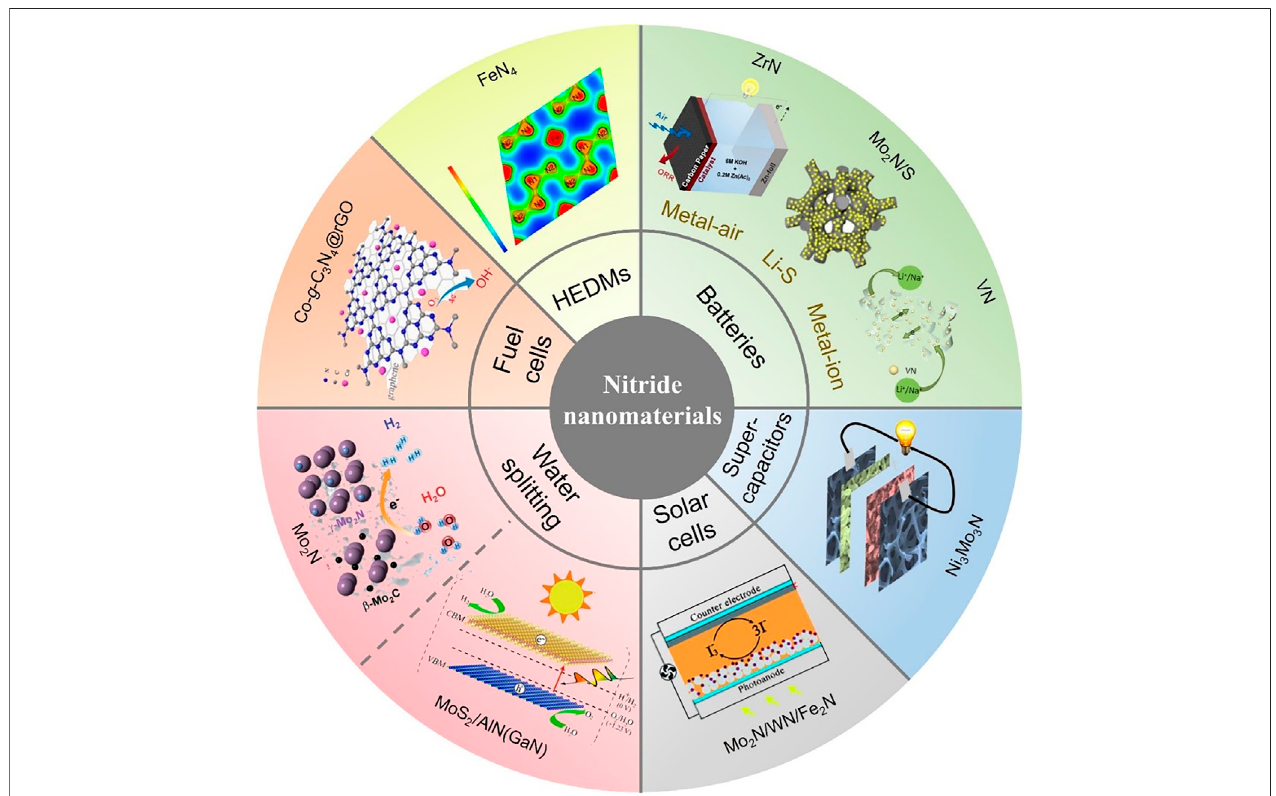
FIGURE 1 | Overview of inorganic nitride nanomaterials for renewable energy applications, including ZrN for zinc-air batteries, mesoporpus Mo 2 N/S for Li-S batteries, hybrid 2D – 0D Graphene – VN quantum dots for lithium and sodium ion batteries, Ni 3 Mo 3 N 3 nanorods for supercapacitors, Mo 2 N or WN or Fe 2 N for solar cells solar cells, heterostructural MoS 2 /AlN(GaN) for photocatalytic water splitting, 3D porous Mo 2 N for electrocatalytic hydrogen evolution, 2D Co-g-C 3 N 4 bulk for fuel cells and FeN 4 as high energy density materials. The inserted graphics are adapted with permission from Li et al. (2011), Chen et al. (2013), Liu and Zhang (2013), Liao et al. (2014), Wang et al. (2016), Bykov et al. (2018), Jiang et al. (2018), Kumar et al. (2020), Yuan et al. (2020).